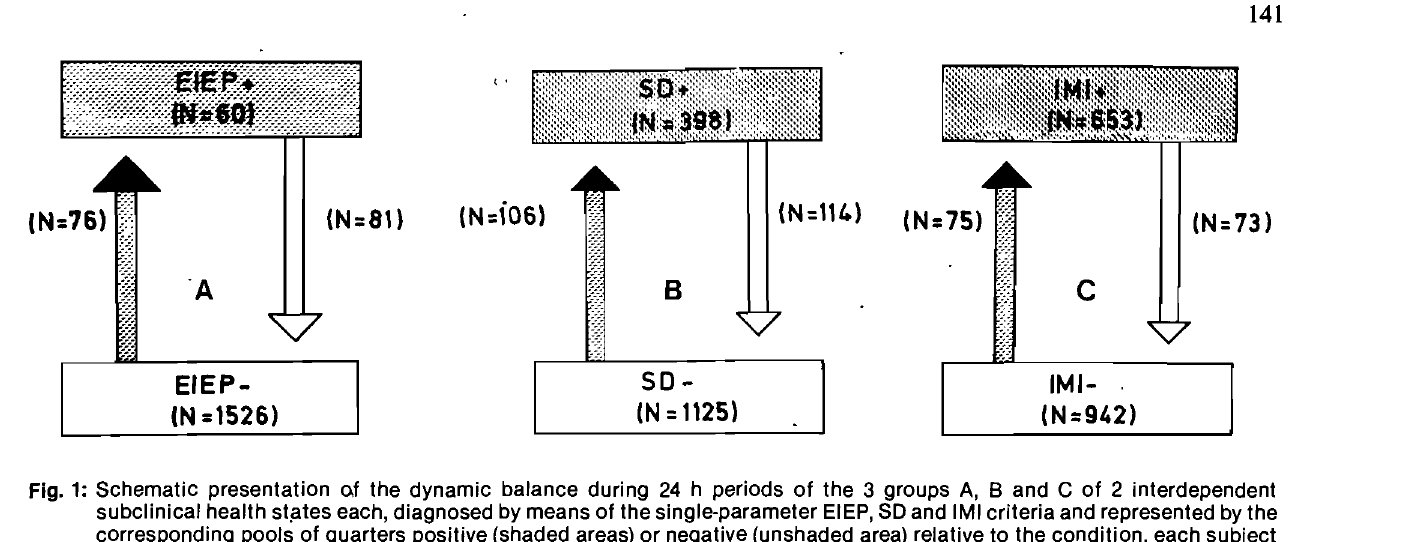
Fig. 1: Schematic presentation o.f the dynamic balance during 24 h periods of the 3 groups A, Band C of 2 interdependent subclinical health stiites each, diagnosed by means of the single-parameter EIEP, SO and IMI criteria and represented by the corresponding pools of quarters p.ositive (shaded areas) or negative (unshaded area) relative to the condition, each subject to fluctuations of persistent (areas), improving (unshaded arrows) and deteriorating (shaded arrows) udder conditions. The arrows indicate dynamic changing of conditions along poorly differentiated pathways apparently related to the deteriora· = tion and restoration of bovine health as suggested by results in Table 2 above. N numbers of quarters involved.